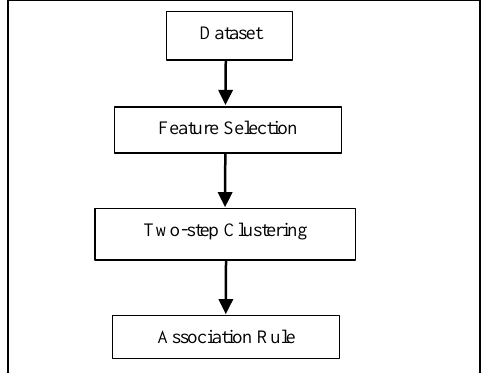
Figure 4. Analyzing steps of